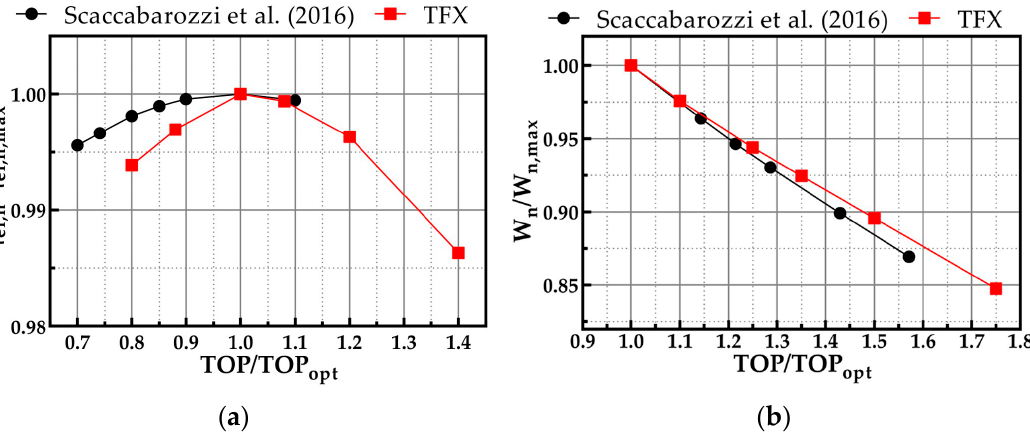
Figure 7. Allam cycle performance as a function of turbine outlet pressure: ( a ) net electric efficiency; ( b ) net specific work. Validation against Scaccabarozzi et al., thermodynamic analysis, and numerical optimization of the NET Power oxy-combustion cycle [26].